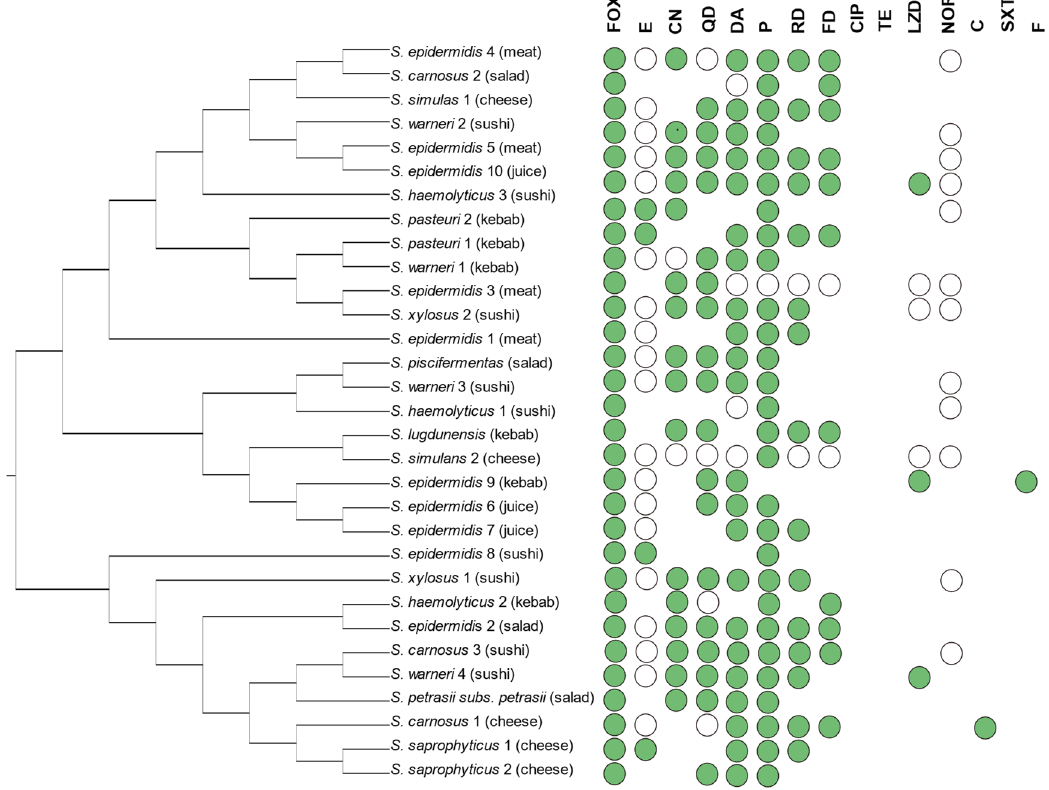
Figure 1. Antibiotic resistance profile of MR-CoNS isolates. Phylogenetic tree was obtained from the analysis of the partial gene sequence of tuf from isolates. Phylogenetic tree was created from DNA sequences using the neighbor-joining method with Kimura 2-parameter distance correction model with 1000 bootstrap replications using the MEGA X software. Abbre- viations: green circles—resistant; circles without filling—medium sensitive, shape completely omitted-sensitive. P—penicillin, QD—quinupristin/dalfopristin, E—erythromycin, FOX—cefoxitin, DA—clindamycin, RD—rifampicin, FD—fusidic acid, CN—gentamycin, NOR—norfloxacin, F— nitrofurantoin, LZD—linezolid, TE—tetracycline, C—chloramphenicol, CIP—ciprofloxacin, SXT— trimethoprim/sulfamethoxazole. Strains antibiogram visualized using